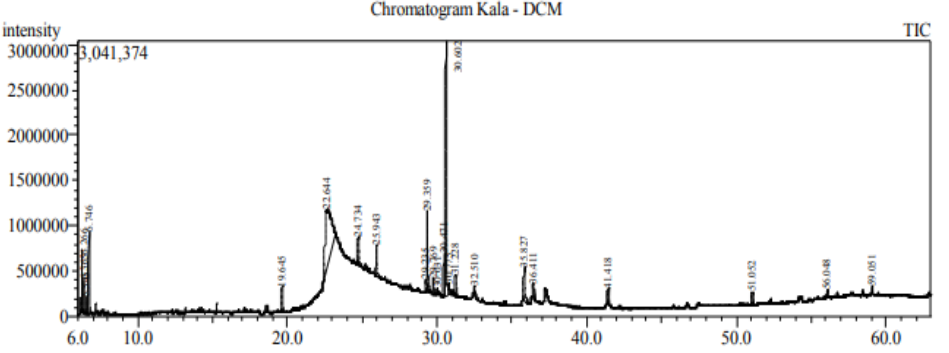
Figure 4. GC–MS chromatogram of the essential oil of Zantedeschia . Table 3. Chemical composition of the essential oil of Zantedeschia .